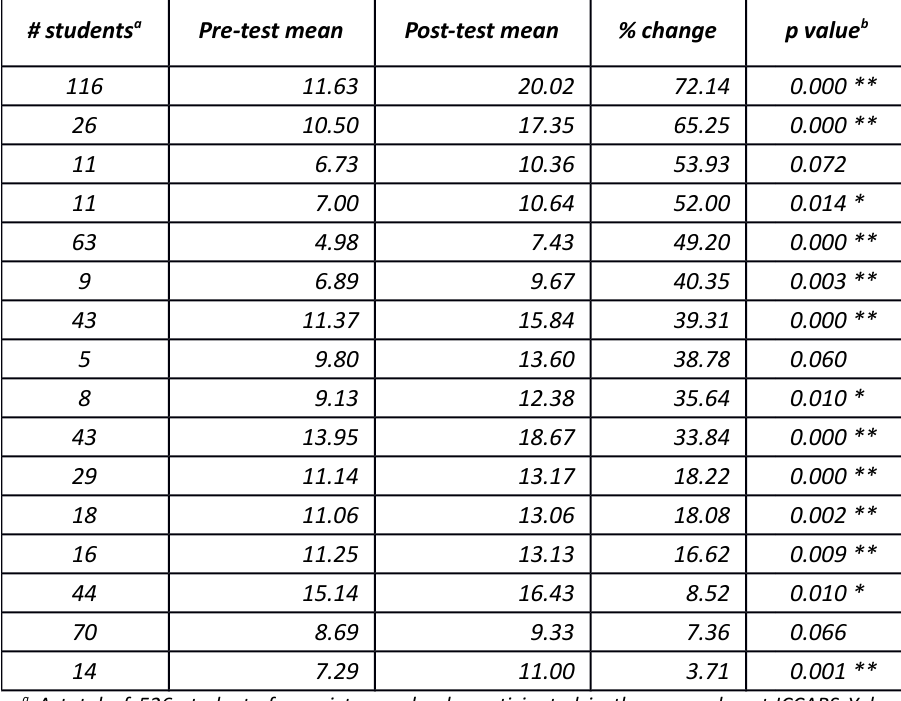
Table 9. Comparison of the exam mean scores of the pre- and the post-ICCARS experience from